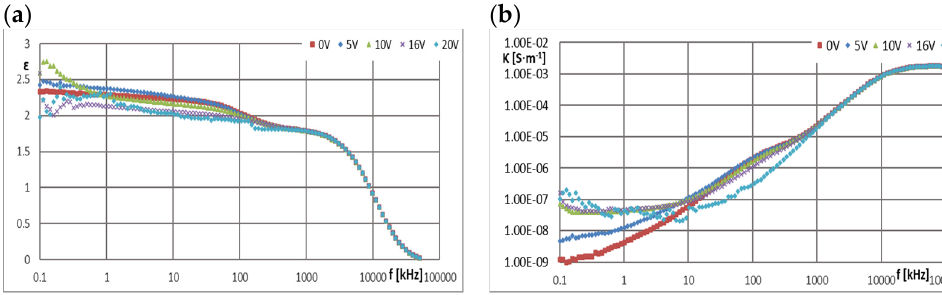
Figure 9. Characteristics: ( a ) ε = f( f ) and ( b ) κ = f( f ) for GP1 + CJ001 at different values of U.